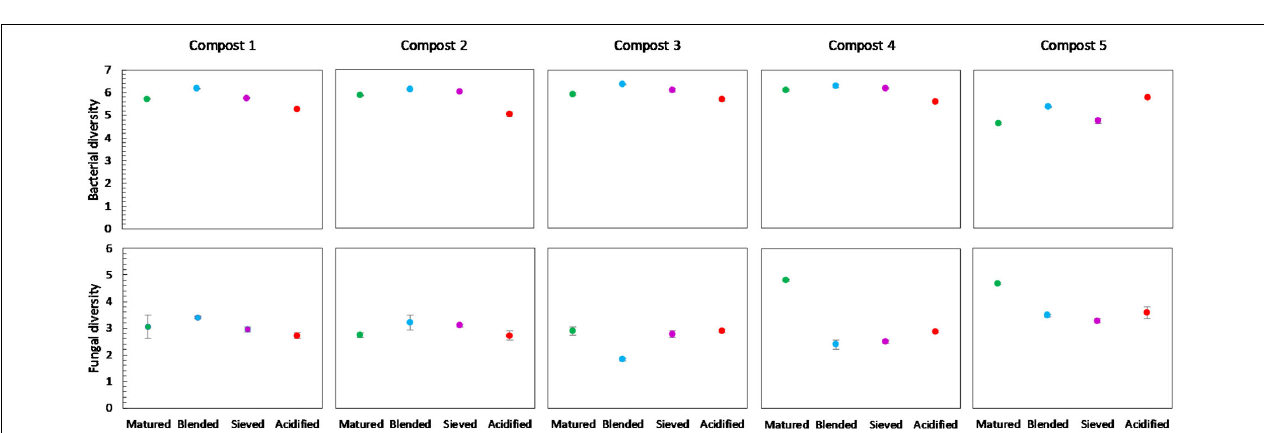
FIGURE 7 | Metabolic characteristics of immature and matured composts in the five compost batches. On top: mean metabolic activity ± standard error in the five compost batches, expressed as mean AWCD (average well color development). Below: mean functional diversity ± standard error in the five compost batches, calculated as the Shannon diversity index from the Biolog Ecoplates data.